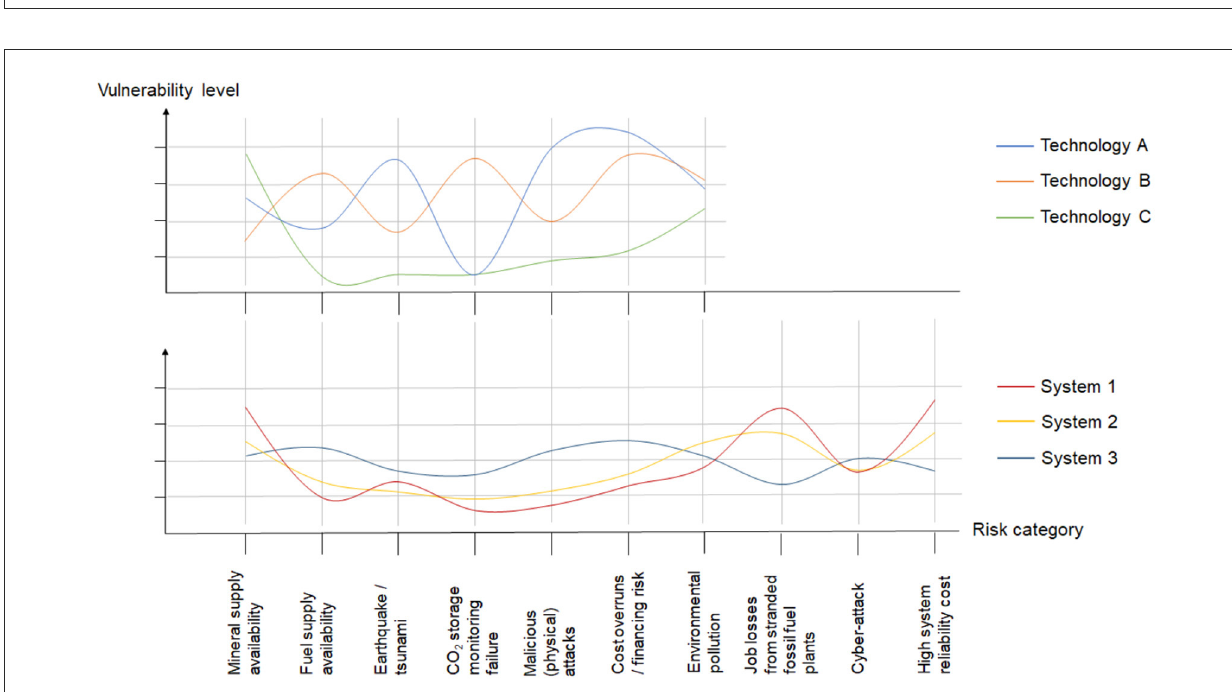
FIGURE2 Example mapping of electricity technologies and system vulnerabilities to different risks. Source: Authors, based on ref. Popper (2019). Vulnerability assessment levels are subjective and illustrative only, to demonstrate the process rather than precise outcome of the assessment.